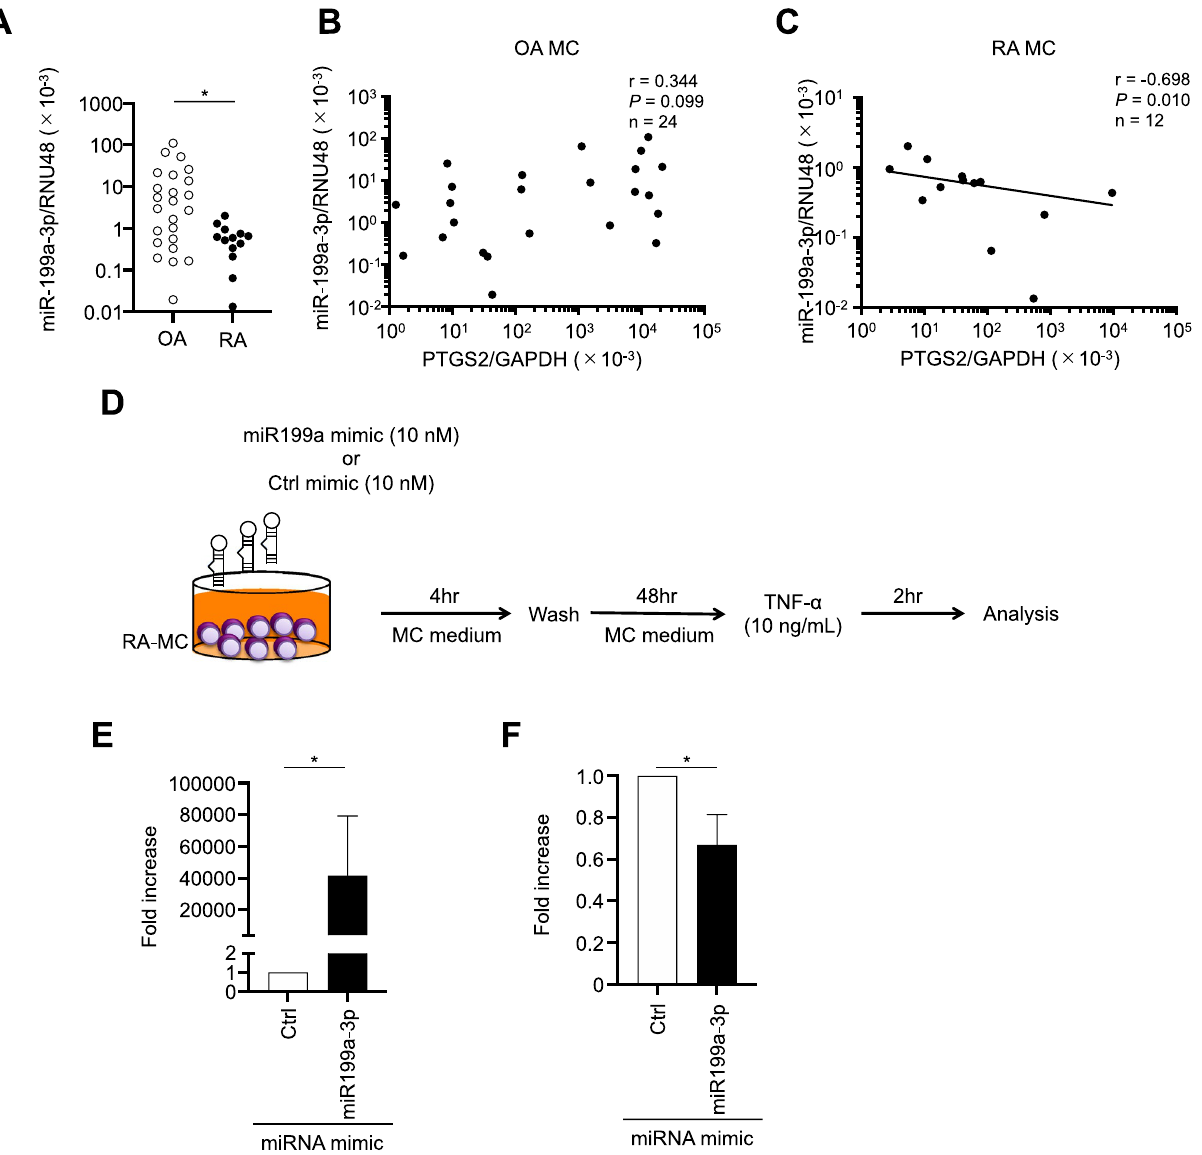
Figure 5. Relationship between miR-199a-3p expression levels and PTGS2 mRNA expression levels in synovium-derived, cultured MCs from RA and OA patients. ( A ) Comparison of miR-199a-3p expression levels in synovium-derived, cultured MCs obtained from OA (n = 24) and RA (n = 12) patients. The data are shown as the ratio of the miR-199a-3p level to the RNU48 level (× 10 –3 , mean ± SEM). Significance was determined using the Mann–Whitney U test. ( B , C ) Plots of expression level of miR-199a-3p/RNU48 vs. expression level of PTGS2/GAPDH in synovium-derived, cultured MCs obtained from OA (n = 24, B ) and RA (n = 12, C ) patients. Each point represents one donor. ( D ) Illustration of procedure for transduction of miRNA mimic to synovium-derived, cultured MCs obtained from RA patients and activation of the cells ( E ). Expression levels of miR-199a-3p mRNA in control miRNA mimic-transduced (Ctrl) and miR-199a-3p mimic-transduced synovium-derived, cultured MCs obtained from RA patients (miR-199a-3p). The expression level of miR- 199a-3p in control miRNA mimic-transduced cells was designated as 1. The results are the mean ± SEM for three different experiments. ( F ) Expression levels of PTGS2 mRNA in control miRNA mimic-transduced (Ctrl), and miR199a-3p mimic-transduced synovium-derived, cultured MCs obtained from RA patients (miR- 199a-3p) in response to 10 ng/mL of TNF-α for 2 h. The expression level of PTGS2 mRNA in control miRNA mimic-transduced cells was designated as 1. The results are the mean ± SEM for three different experiments. *indicates P <